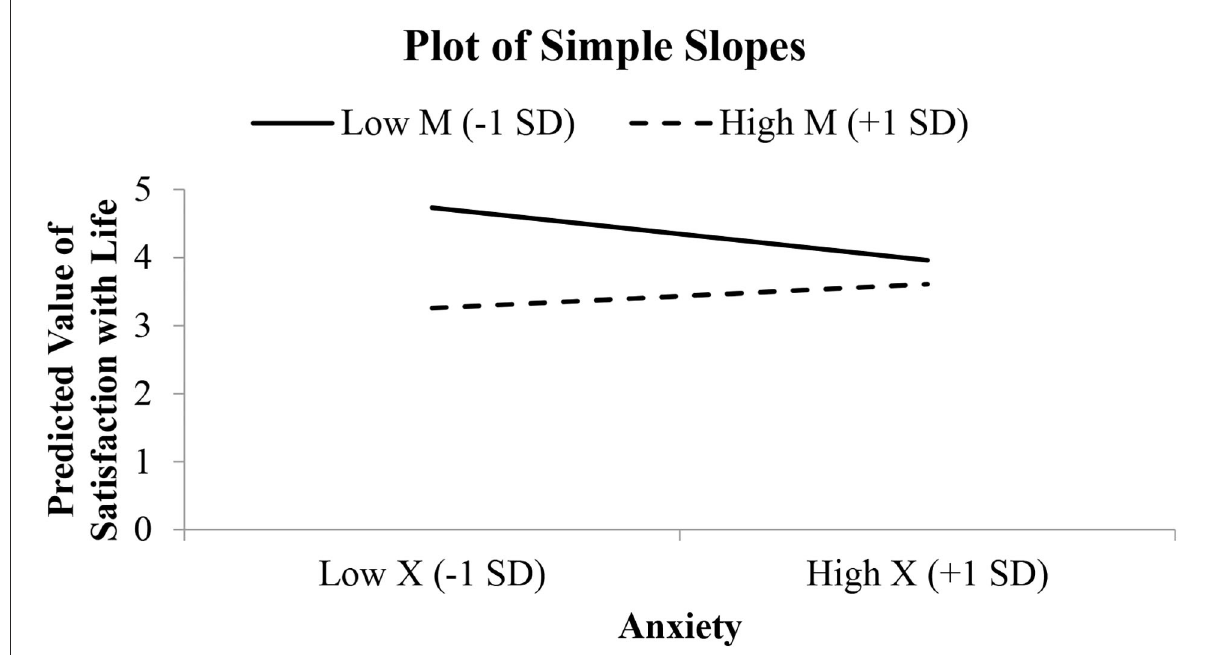
FIGURE5 Simple slope graph for the model relating satisfaction with life to anxiety, perceived burdensomeness, and their